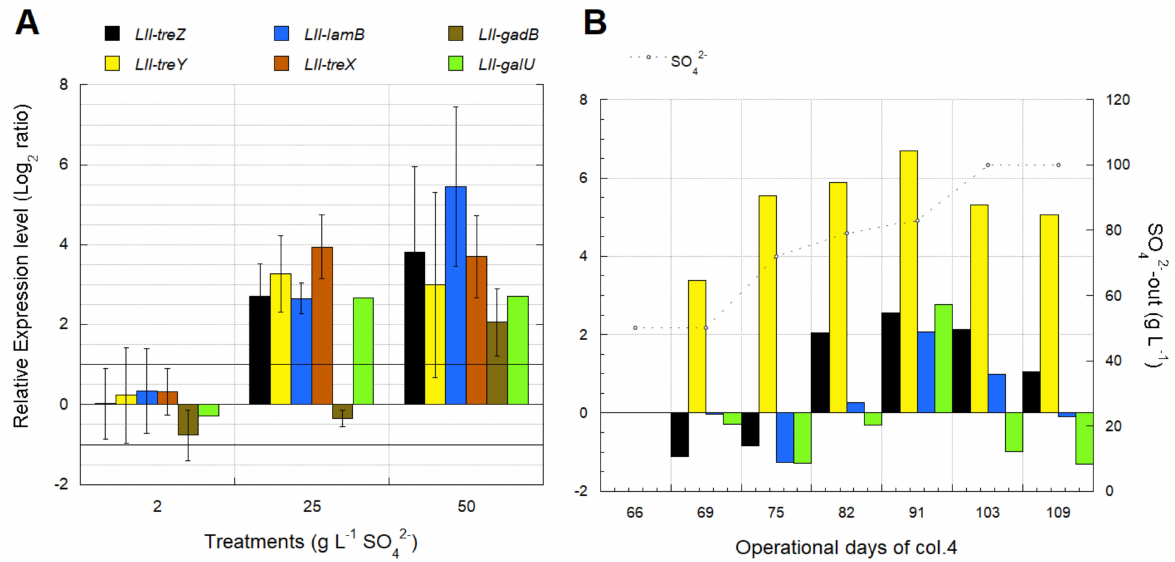
Figure 9. Transcriptional dynamics of trehalose synthesis genes of L. ferriphilum (LII) in response to ( A ) three different SO 42 − levels in pure cultures of the type strain DSM 14647, using as control one biological replicate of the cultures with 2 g L − 1 SO 42 − , and ( B ) variations in the SO 42 − concentration produced by two increments of feeding SO 42 − at operation days 68 and 103 in a bioleaching column, respectively, using as control the sample taken on operation day 66. Vertical bars represent the standard deviation (SD) calculated with biological replicates. Significant differences in relative expression were adjusted at − 1 < Log 2 ratio < 1 (horizontal black lines). In ( B ), the X -axis corresponds to operation days at the sampling time of